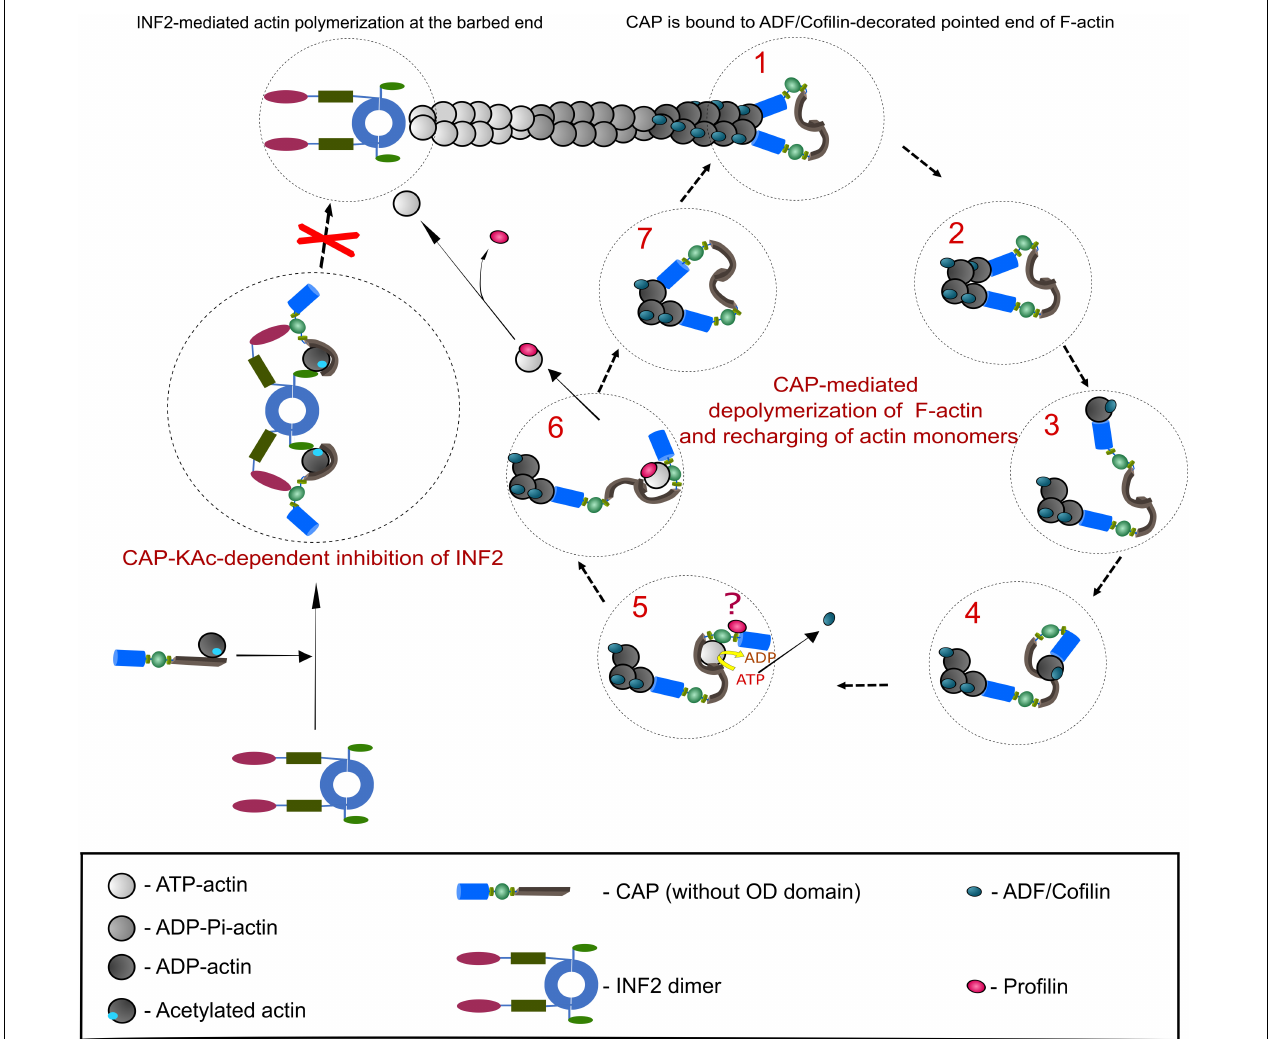
FIGURE 2 | CAP-mediated regulation of actin dynamics. This scheme depicts the best studied CAP-dependent mechanisms relevant for actin dynamics. A detailed description of both mechanisms is provided in the section ‘Function of CAP in actin dynamics’, which also includes additional actin regulatory mechanisms that depend on CAP. Right panel presents a stepwise CAP-dependent depolymerization mechanism of ADF/Cofilin-decorated F-actin pointedends (based on Kotila et al., 2018, 2019). Although CAP forms hexamers, for the purpose of clarity we depicted them as dimers. Additionally, OD was removed. Two HFD (blue) of CAP dimer bind to ultimate and penultimate actin subunit at ADF/Cofilin-decorated pointed end (step 1). HFD thereby destabilizes intermolecular interaction of both actin subunits (step 2). HFD removes ADF/Cofilin-bound ultimate actin subunit from pointedend (step 3) and hands it over to CARPdomain (gray; step 4). Binding of CARP and WH2 (green) domains releases ADF/Cofilin and HFD from G-actin. Next, G-actin is recharged (ADP to ATP) and most likely transferred to Profilin (red) that binds CAP’s P1 motif (step 5 and 6). Question mark in step 5 indicates that the functional relationship between CAP and Profilin is still unclear. Polymerization competent, Profilin-bound ATP-G-actin can now be used for F-actin assembly. Step 7 indicates that a new round of CAP-dependent depolymerisation of ADF/Cofilin-bound actin starts. Left panel: in addition to actin depolymerisation at ADF/Cofilin-decorated pointed ends, CAP can impede F-actin assembly by inhibiting INF2 (depicted as dimer; based on Mu et al., 2019). Binding of a complex composed of lysine-acetylated (KAc-) actin and CAP to INF2’s DID (Diaphanous inhibitory domain, magenta) and DAD (Diaphanous autoregulatory domain, light green) keepINF2 in an inactive state, thereby inhibiting INF2-mediated actin